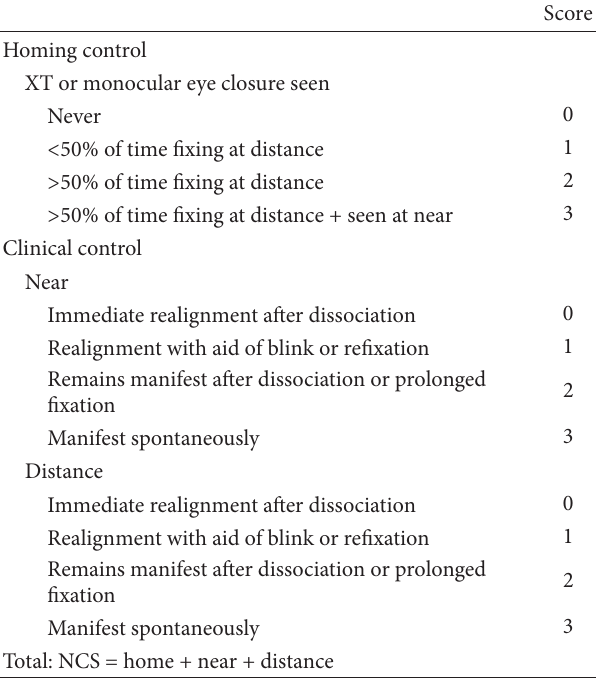
Table 1: The revised Newcastle Control